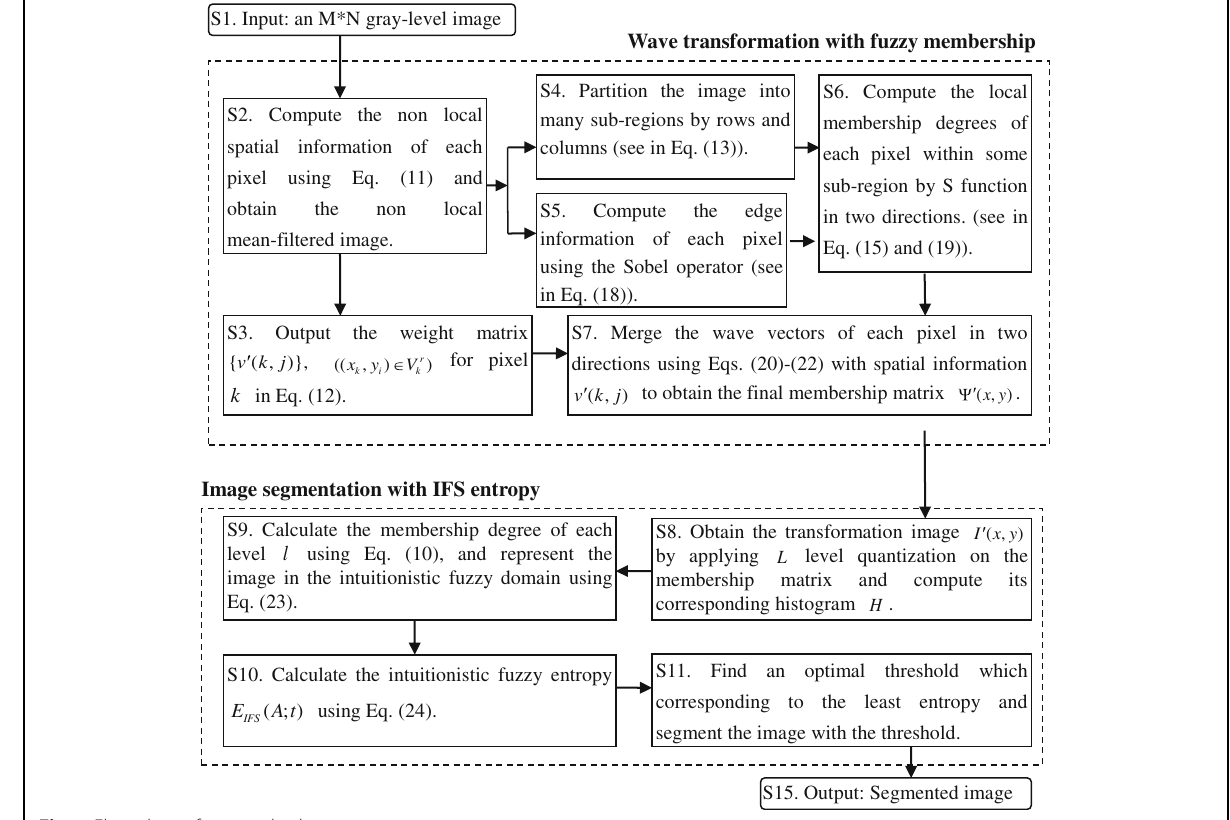
Fig. 5 Flow chart of our